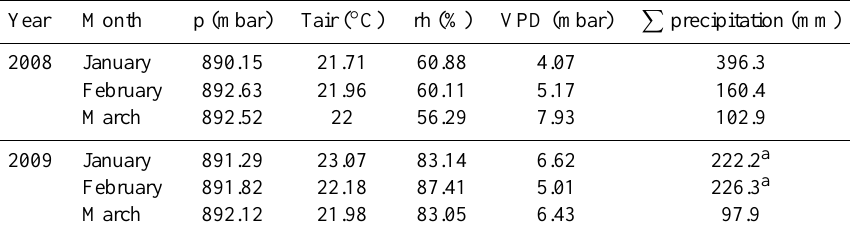
Table 2. Monthly mean of basic meteorological variables for the January – March in 2008 and 2009 measured in Kataba forest. Values for precipitation are given as monthly sums. Measurements were undertaken at a height of